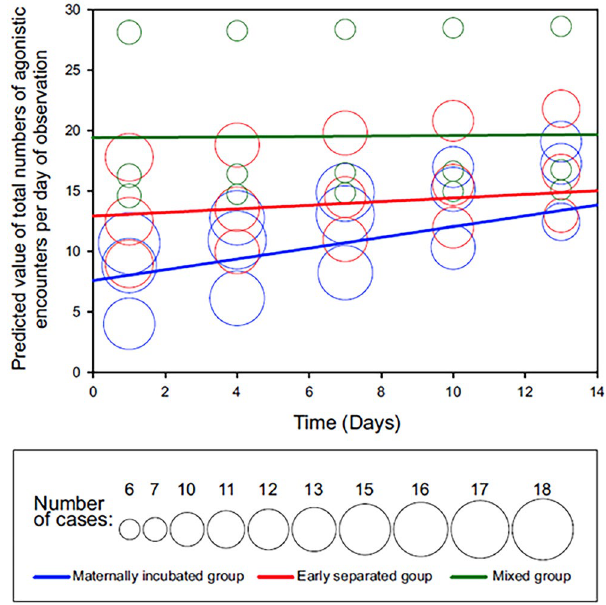
Figure 1. Bubble plot of predicted values of total numbers of agonistic encounters plotted against Time according to Group. The high predicted values of the total numbers of agonistic encounters per day equal to about 28 for the Mix group are not outliers. These high values were achieved by seven different individuals and occurred in each of the seven groups with the frequency between 1 and